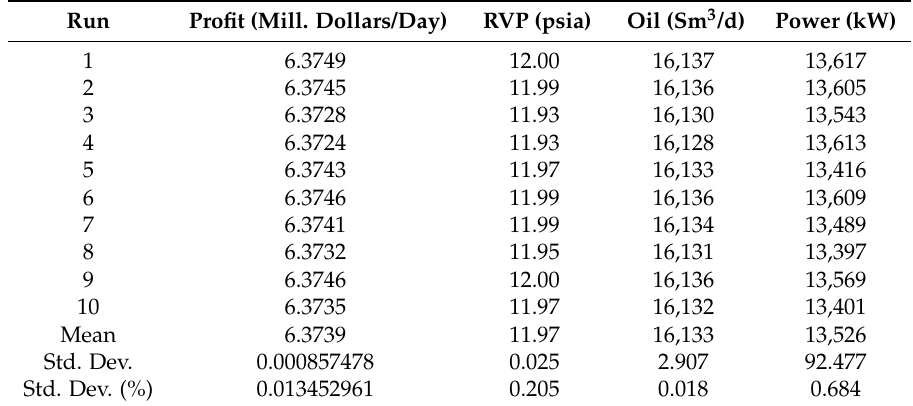
Table 5. Processsimulation output using the 10 NSGA-II optimal solutions found using the surrogate models cf. Table